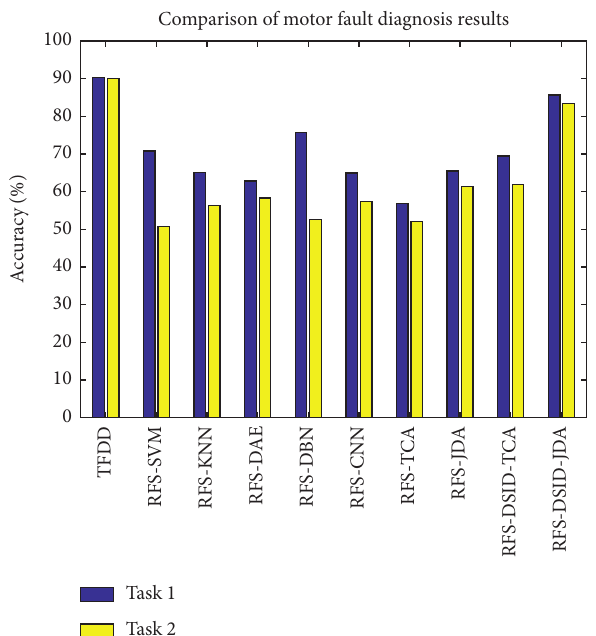
Figure 19: Comparison of fault diagnosis results of comparative